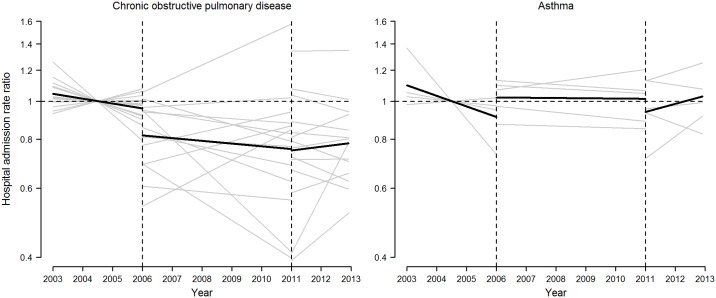
Population-average and province-specific segmented linear trends in hospital admission rate ratios for chronic obstructive pulmonary disease and asthma in selected Spanish provinces, 2003–2012.Province-specific segmented linear trends in hospital admission rate ratios (gray lines) were obtained from overdispersed Poisson additive models with distinct linear segments within the 2003–2005 pre-ban, 2006–2010 partial ban, and 2011–2012 comprehensive ban periods, and adjusted for seasonality, day of the week, temperature, influenza epidemics, acute respiratory infections, and pollen counts for asthma-related admissions (only available in Asturias, Barcelona, Madrid, Murcia, and Zaragoza). Pooled segmented linear trends (bold black lines) were obtained from random-effects multivariate meta-analyses on province-specific estimates of segmented regression coefficients. The reference time point (rate ratio = 1) was set at the midpoint pre-ban period (July 1st, 2004). Vertical dashed lines represent the dates at which the partial and comprehensive smoking bans entered into force on January 1st, 2006, and January 2nd, 2011, respectively.